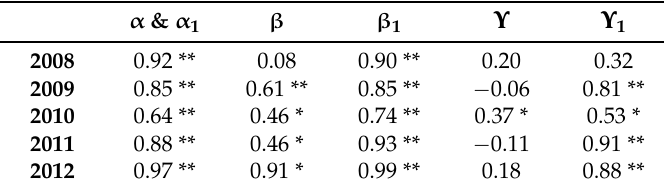
Table 3. Correlation among dengue incidence and risk indices. Table 1. Risk measure using the LISA classification. Table 1. Risk measure using the LISA classification.